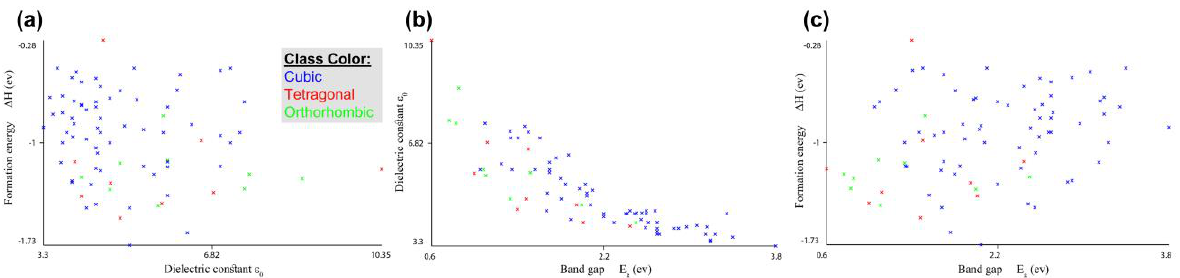
Figure 2. Formation energy and structural stability: the relationship between attributes obtained using WEKA. ( a ) Formation energy vs dielectric constant, ( b ) Dielectric constant vs band gap and ( c ) formation energy vs band gap.